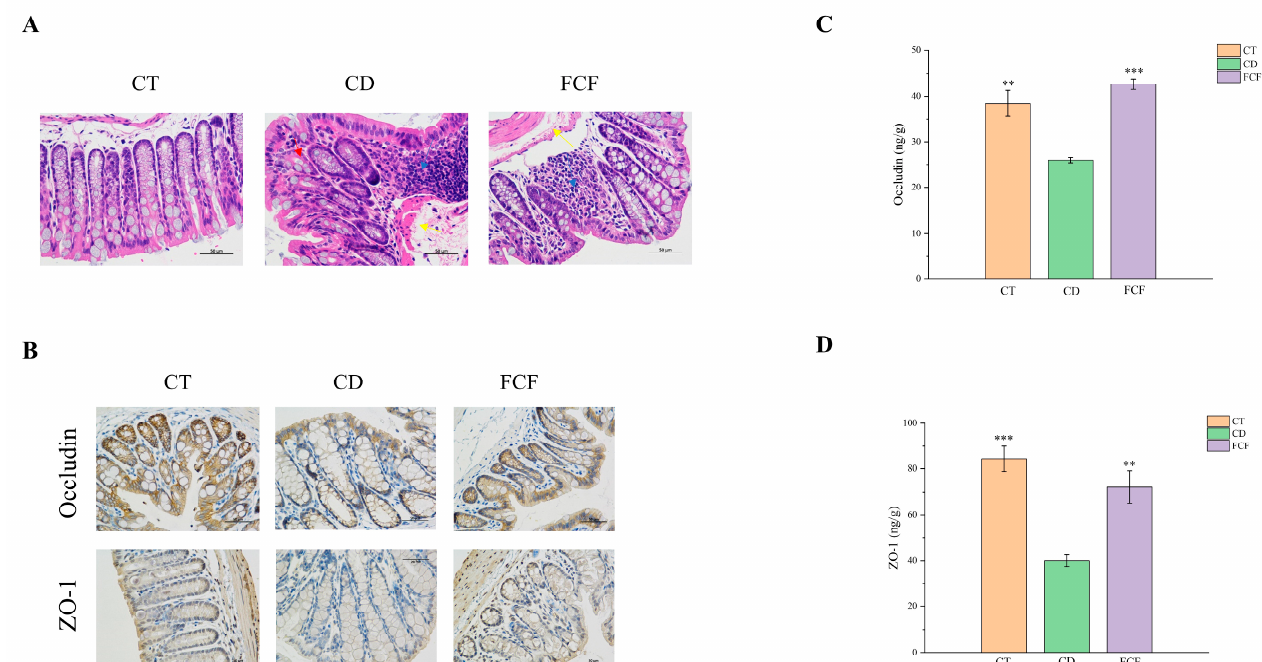
Figure 2. ( A ) Effect of FCF supplementation on intestinal histomorphology in mice with circadian rhythm disruption (HE, × 400). ( B ) Immunohistochemistry of occludin and ZO-1 of the three groups (Immunohistochemistry, × 400). Effects of FCF on the expression of tight junction proteins occludin ( C ) and ZO-1 ( D ) in the colon of mice with circadian rhythm disorder. ** p < 0.01, *** p < 0.001, compared with the CD group.